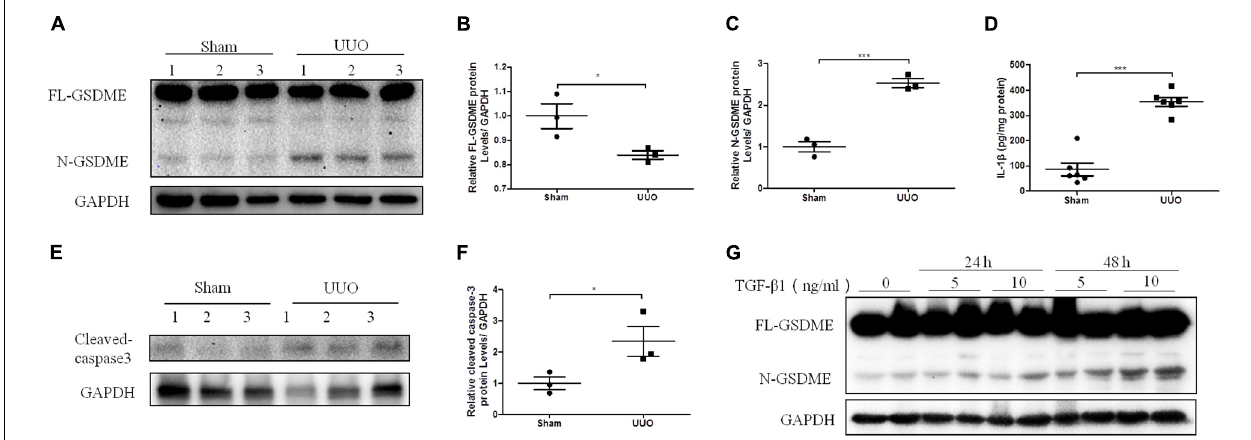
FIGURE 1 | Gasdermin E (GSDME) cleavage is induced in unilateral ureteral ligation (UUO) mice kidneys and TGF- β 1-treated renal tubular epithelial cells. Mouse kidney tissues subjected to UUO and human renal epithelial cells treated with TGF- β 1 were used to detect the expression of GSDME and pyroptosis. (A–C) Western blotting analysis of full length gasdermin E (FL-GSDME) and N-GSDME in kidneys of UUO mice ( n = 3). (D) Secretion of IL-1 β in kidneys of UUO mice ( n = 6). (E,F) Western blotting analysis of cleaved caspase-3 in kidneys of UUO mice ( n = 3). (G) Western blotting analysis of FL-GSDME and N-GSDME in HK-2 cells challenged with TGF- β 1 at a dosage of 5 or 10 ng/mL for 24 or 48 h. For the cell experiments, two independent experiments were performed. The quantitative results were shown as the means ± SEM. * p < 0.05; *** p < 0.001.